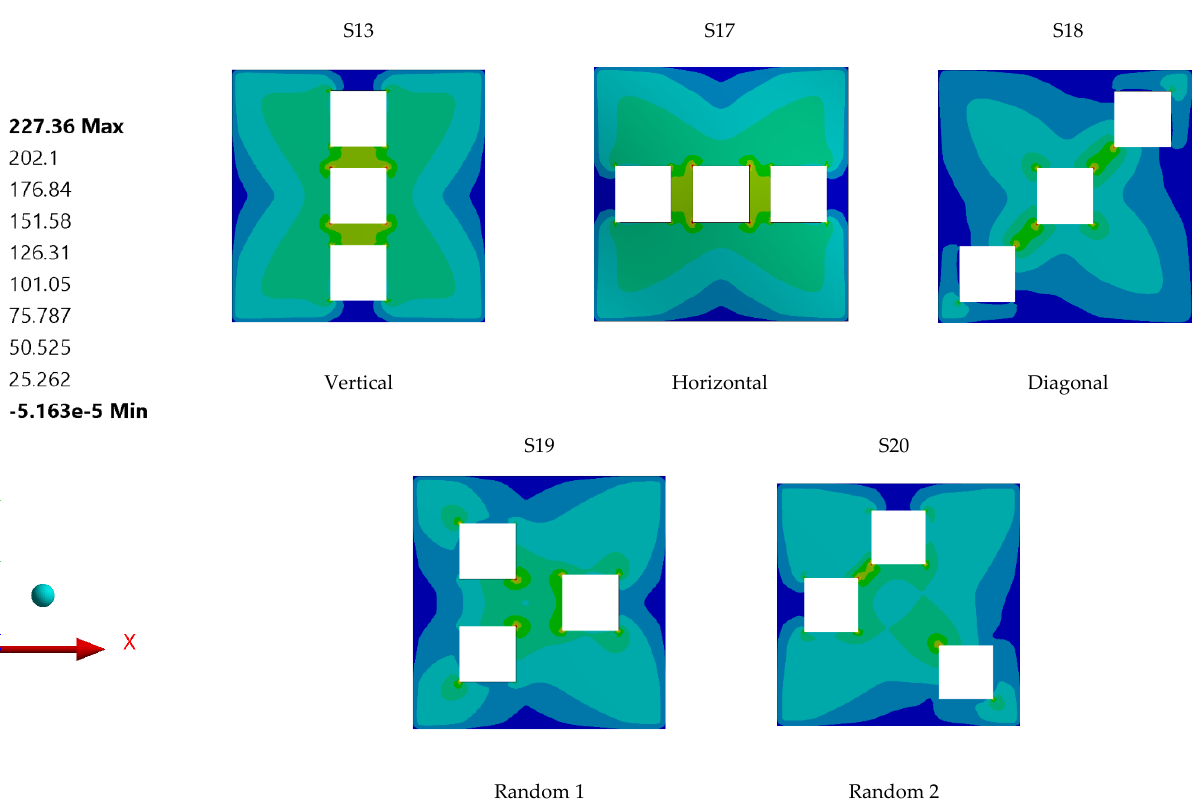
Figure 23. Stress contour areas for individual steel plate specimens with differing plate opening positions.